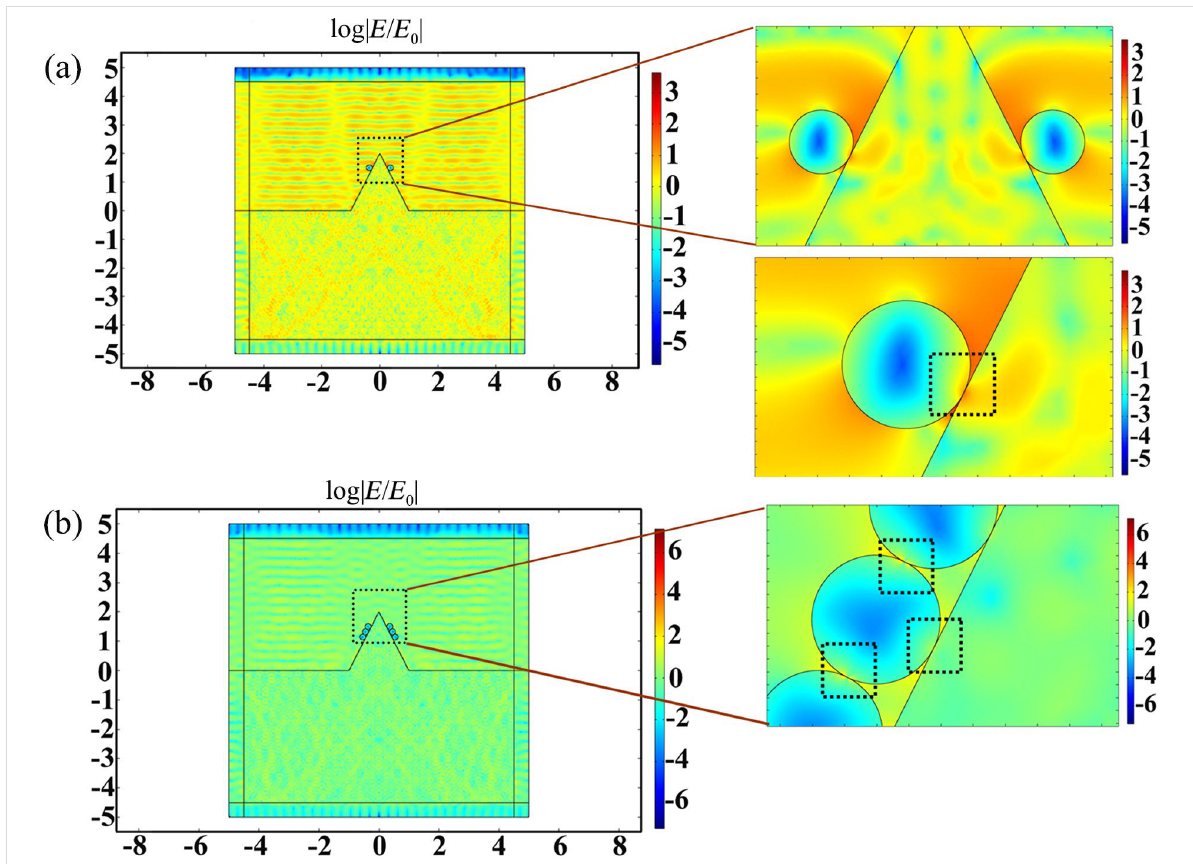
Figure 10: (a) Electric field distribution of a single Ag nanoparticle with a radius of 100 nm on the pile-up of Cu substrate. (b) Electric field distribution of three Ag nanoparticles with a radius of 100 nm on the pile-up of Cu